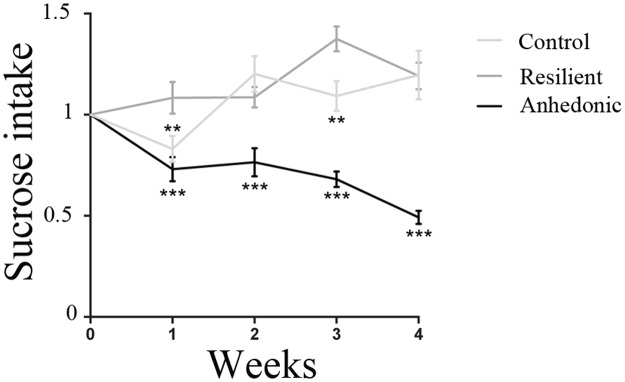
Sucrose consumption following four weeks of the CMS regime.Four weeks exposure to chronic mild stressors resulted in a significant decrease of sucrose consumption of the anhedonic animals (n = 10) when compared to unchallenged controls (n = 10). The graph shows sucrose consumption of the control (n = 10), resilient (n = 10) and anhedonic-like (n = 10) animals at 4 different time points (week 1; week 2; week 3 and week 4). Significant differences on sucrose consumptions were detected among goups (p<0,0001) at different time points (p = 0,0084). The sucrose intake of anhedonic-like animals was significantly diminished when compared to control and resilient animals. Two-way ANOVA followed by post hoc Tukey´s multiple comparison test. * p<0,05; **p<0,01; ***p<0,001. Data is presented as mean (±SEM) sucrose intake, indexed to baseline values.